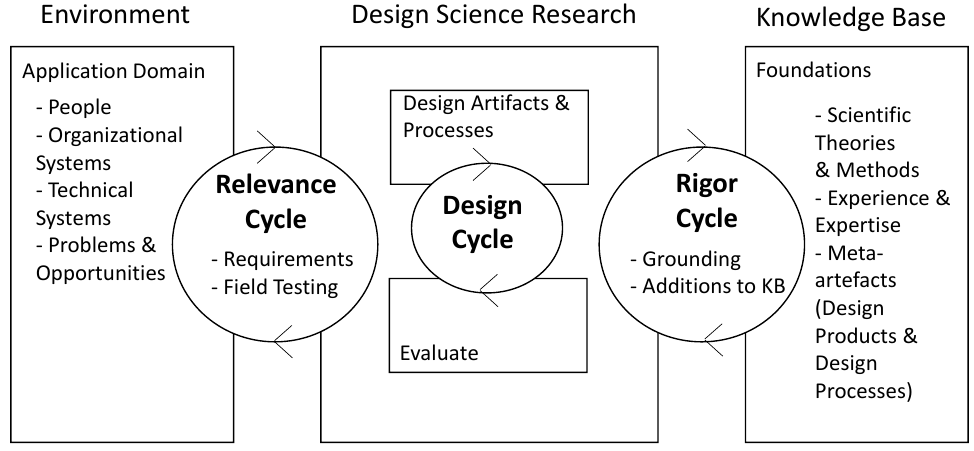
Figure 2 . Three main research cycles that are discussed in the design science literature